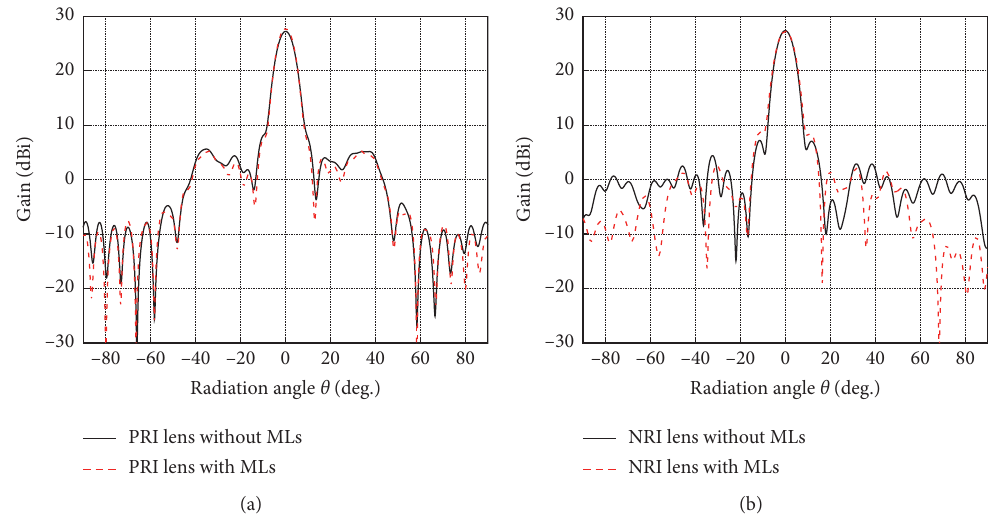
Figure 9: The comparison of radiation patterns of lens antennas on the yz plane. (a) PRI lens with and without MLs. (b) NRI lens with and without